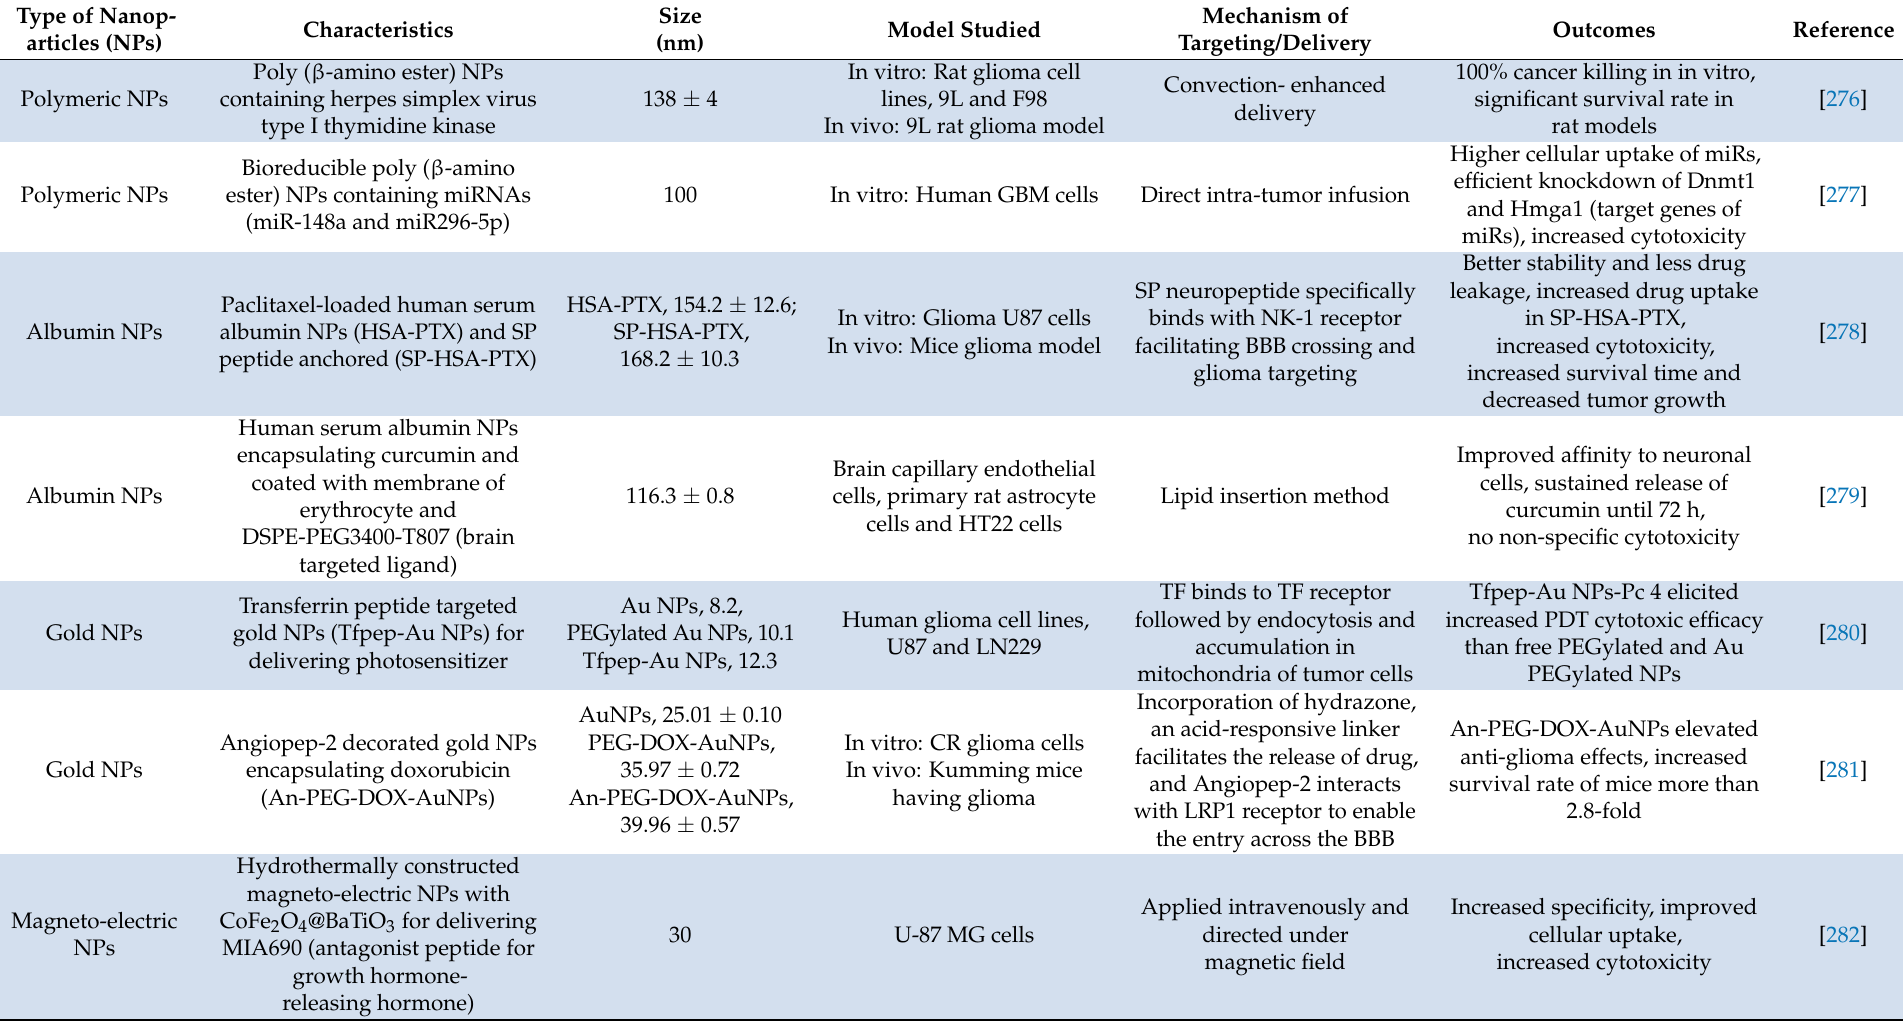
Table 1. Smart nanomaterial formulations used in brain cancer theranostics